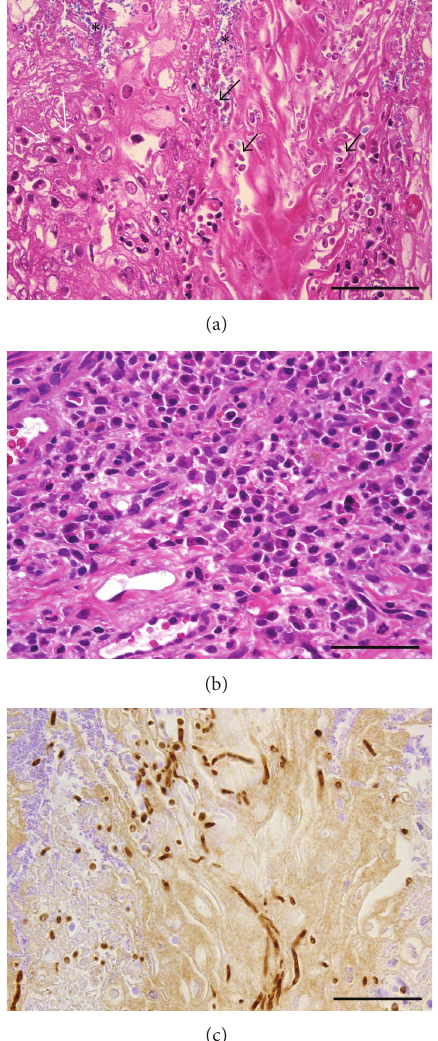
Figure 4: Mucosal and submucosal inflammation induced by C. albicans. (a) Neutrophils infiltrate (white arrows) in the hyperplastic mucosal surface with fungal (black arrows) and bacterial infection (asterisk) in the AC group. (b) Lymphoplasmacytic cell infiltration in the submucosa are observed in the AC group. (c) Fungi positive for a C . albicans antigen by immunohistochemical staining are seen in hyperplastic mucosal surface. Scale bar, 50 𝜇